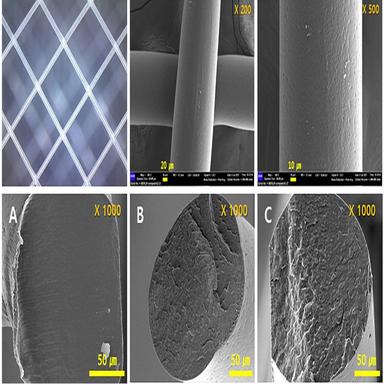
Drug particle distribution analysis of PTX/PCL scaffolds with different drug concentrations (top: surface image of PTX/PCL scaffold, bottom: cross-section image of PTX/PCL scaffold, A: drug-free, B: 10% (w/w), C: 30% (w/w).